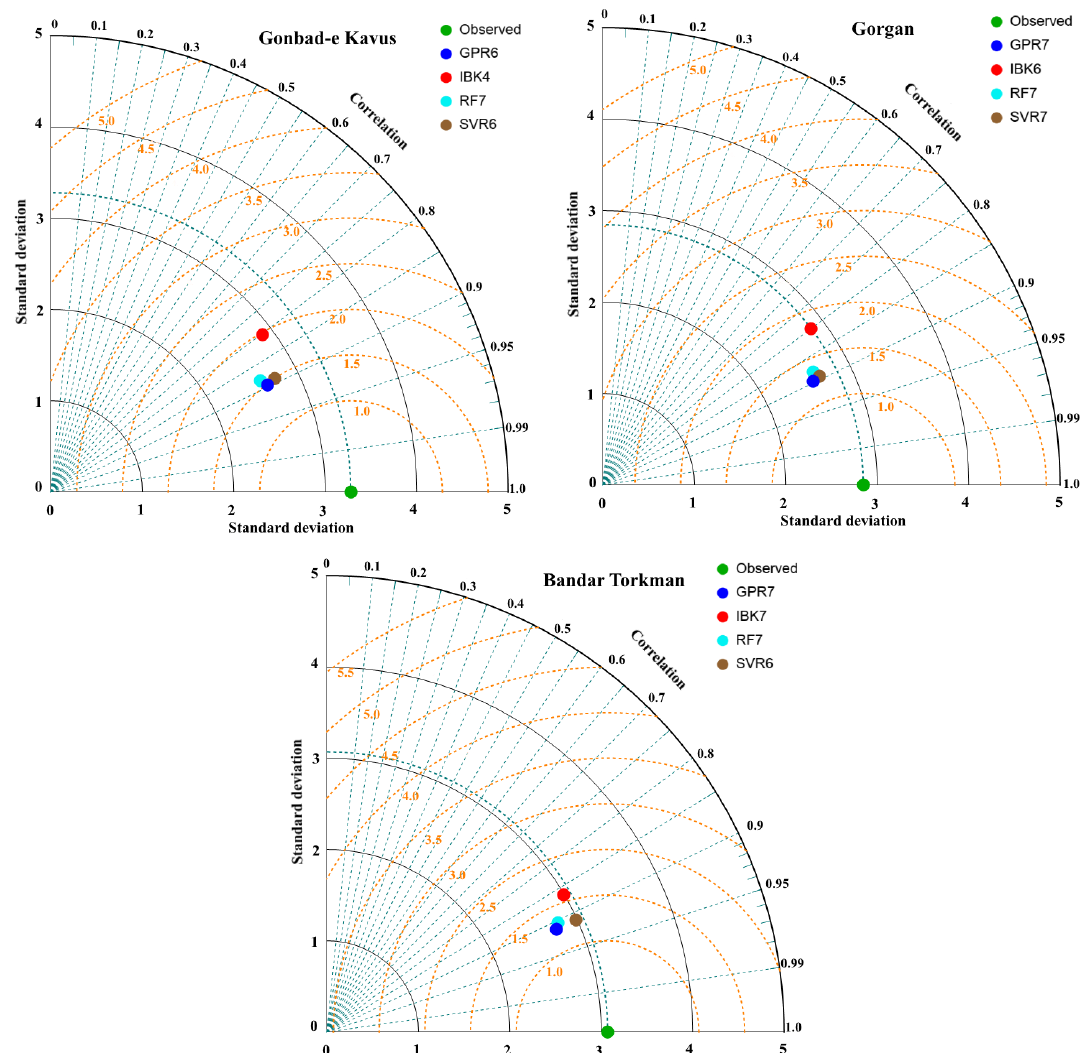
Figure 4. Taylor diagrams of estimated PE values using the most accurate models.